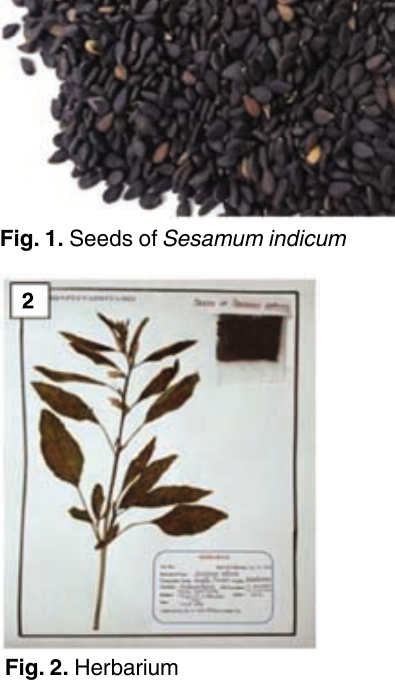
Fig. 2. Herbarium Aqueous extract from seeds of S. indicum The seeds of S. indicum were cleaned, dried and sieved. Then they were crushed and defatted using hexane as a solvent. The defatted residue was then allowed for air drying and kept in Soxhlet apparatus for hot aqueous extraction. rotary evaporator. The yield of extract was calculated from the extract obtained (Aathira et al ., 2021). Finally, the resultant product was stored in refrigerator for further